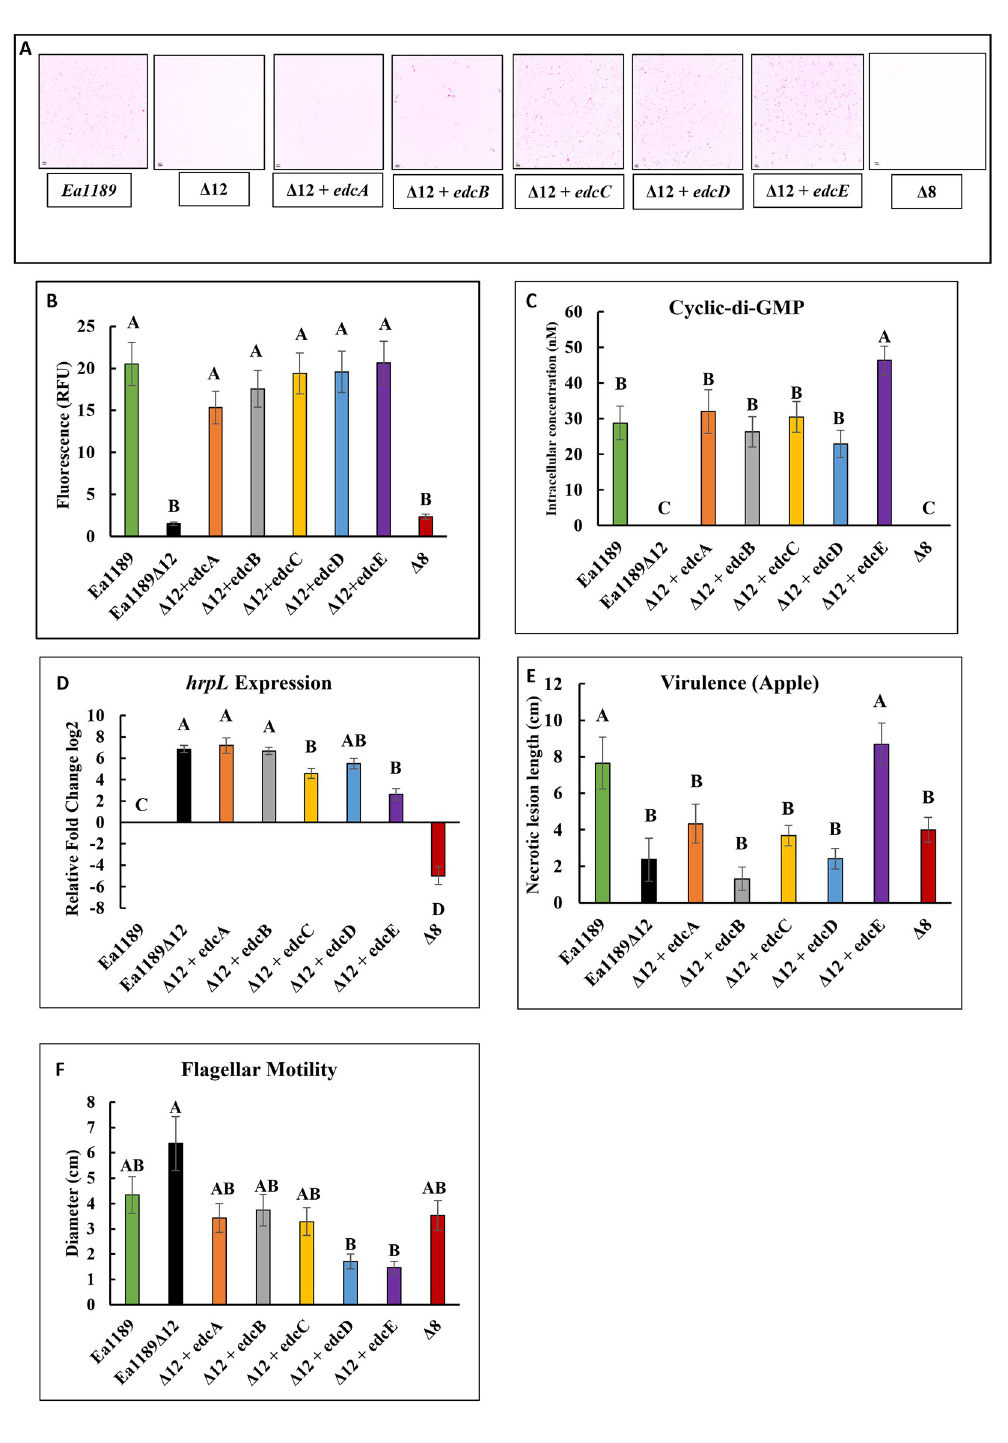
Fig 2. Edcs differentially regulate biofilm formation and virulence. A) Confocal images (color inverted) and B) relative GFP intensity of flow cells inoculated with GFP labelled WT Ea1189, Ea1189 Δ 8 Ea1189 Δ 12 and Ea1189 Δ 12 complemented with individual edc genes. Bacterial inoculum was introduced into the flow cells and allowed to incubate for 1 h before being flushed out, followed by incubation under flow for 5 h. The flow cells were then imaged along a z-plane to assess the volume of bacterial adhesion to within the chamber. Ea1189 Δ 12 and Ea1189 Δ 8 are impaired in biofilm formation relative to